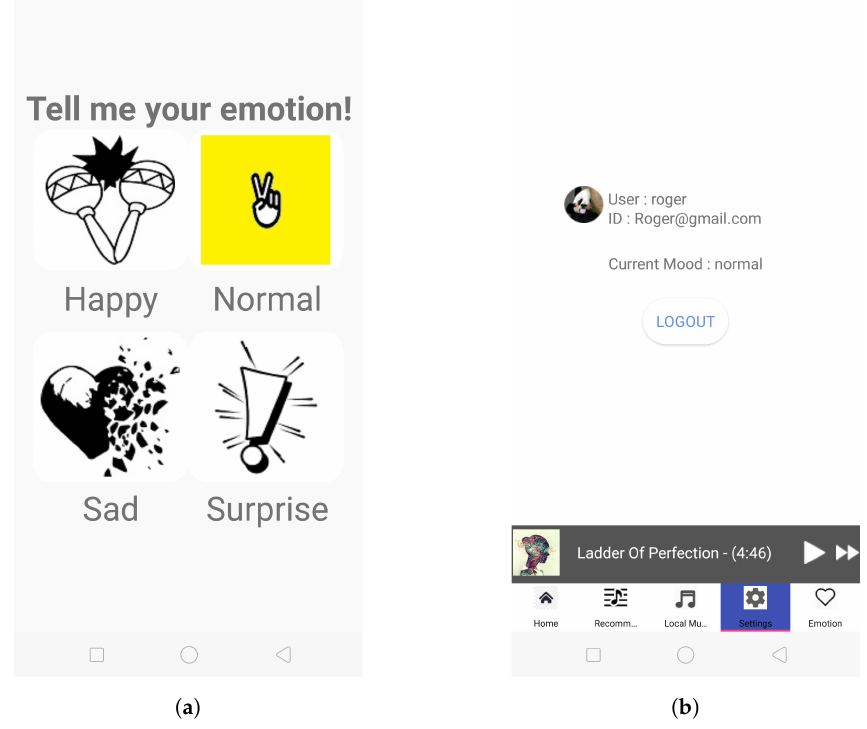
Figure 5. ( a ) list of emotions where a user can select his current emotion; ( b ) user information.